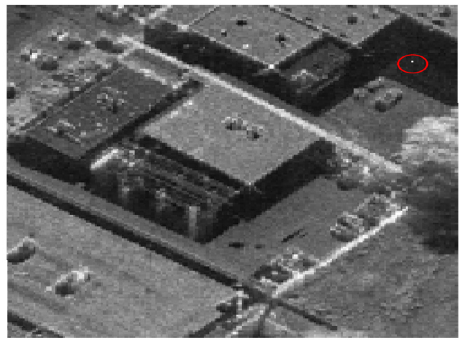
Figure 11. Focused SAR image with 0.3 m resolution for simulation.